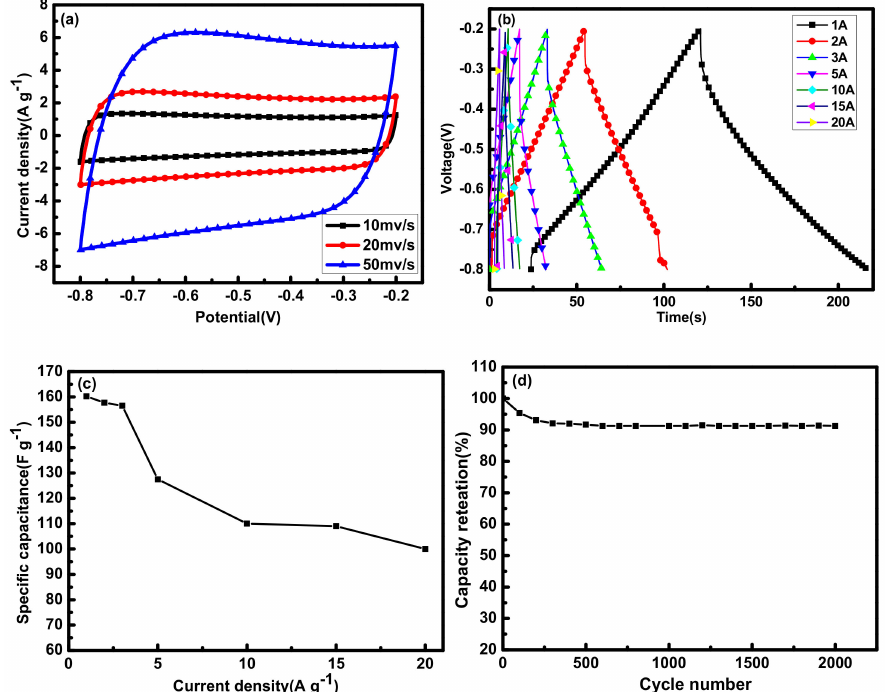
Figure 5. Electrochemical characterization of sample 2APCNs-2: ( a ) CV curve at different scan rates; ( b ) Constant current charge and discharge curve with current density from 1 A g − 1 to 20 A g − 1 ; ( c ) Line diagram of specific capacitance at different current densities; ( d ) Cyclic stability curve with current density of 1 A g − 1